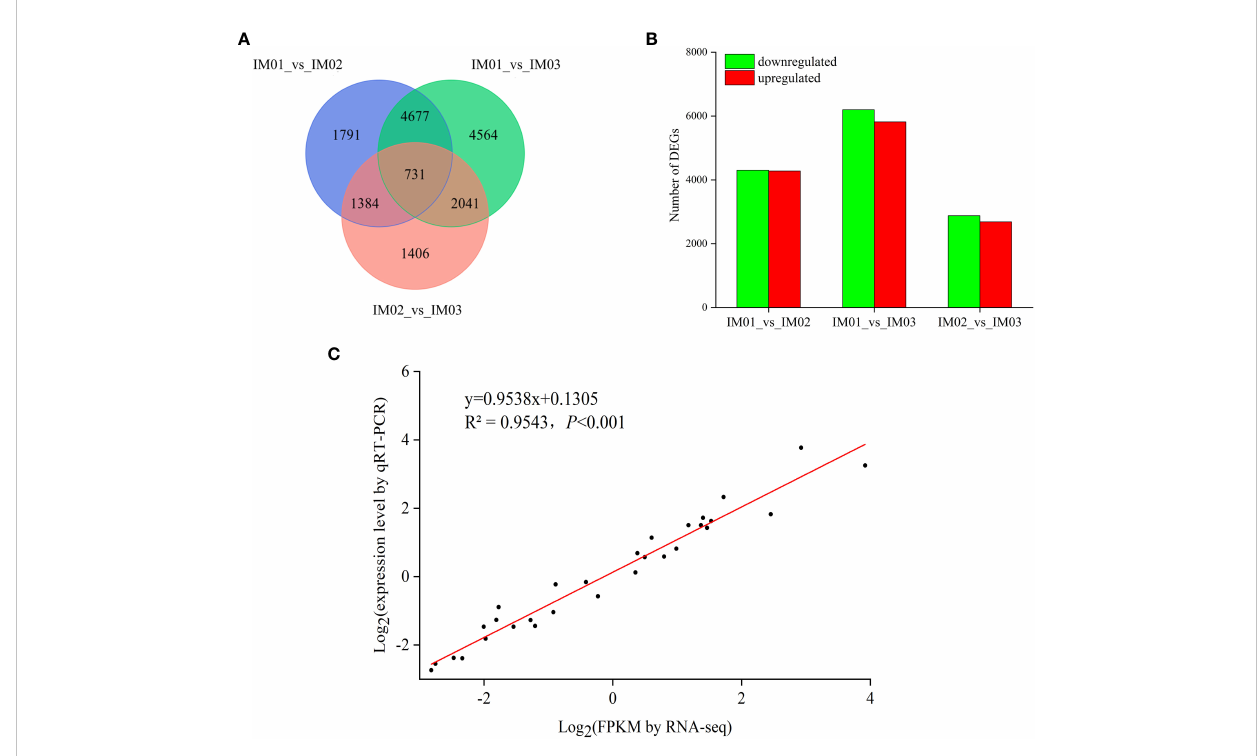
FIGURE 4 DEGs in regenerated bulbs of F. hupehensis . (A) . Venn diagram of DEGs for different comparisons: “ IM01_vs_IM02 ” , “ IM01_vs_IM03 ” , and “ IM02_vs_IM03 ” . (B) . The number of up- and downregulated genes for different comparisons. (C) . Linear regression of RNA-Seq and qRT-PCR data that are expressed as a log 2 fold